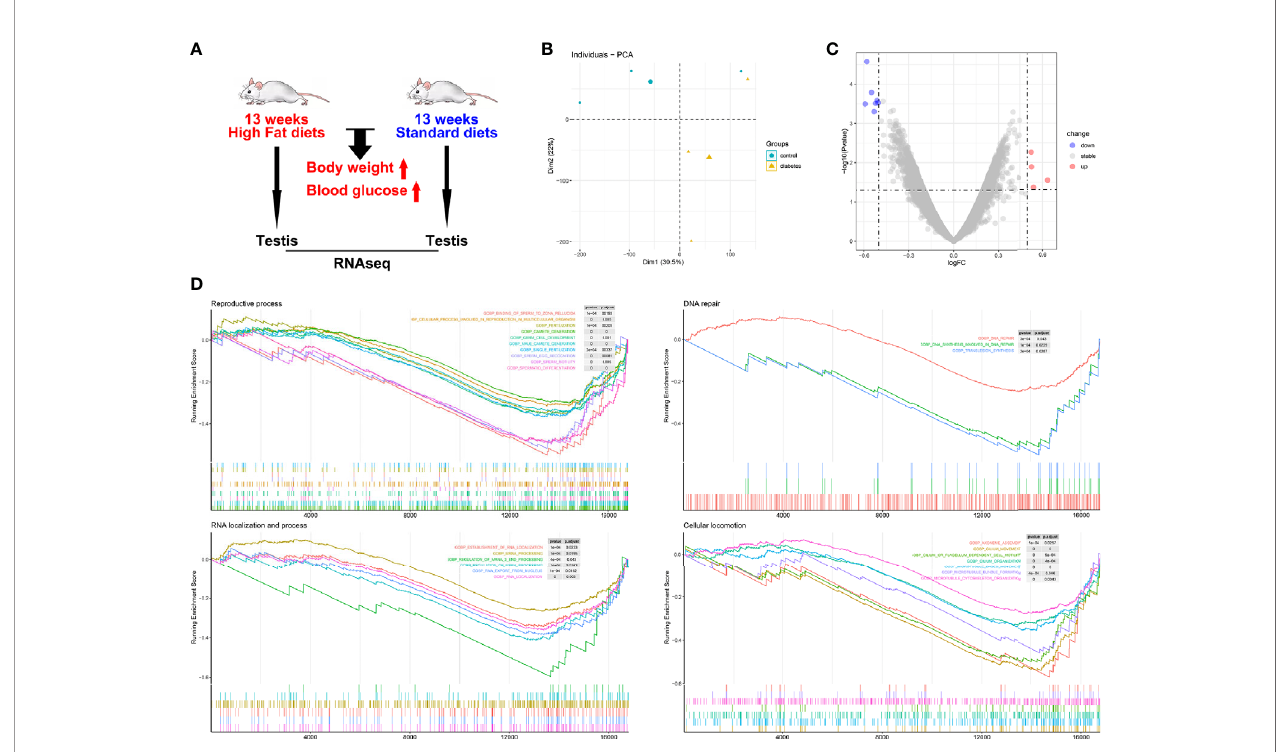
FIGURE 4 | Spermatogenic dysfunction in diabetic mice. (A) Characteristics of enrolled animals in GSE44301; (B) Principal component analysis; (C) Differentially expressed genes (DEGs) between diabetic and control mice; (D) Gene set enrichment